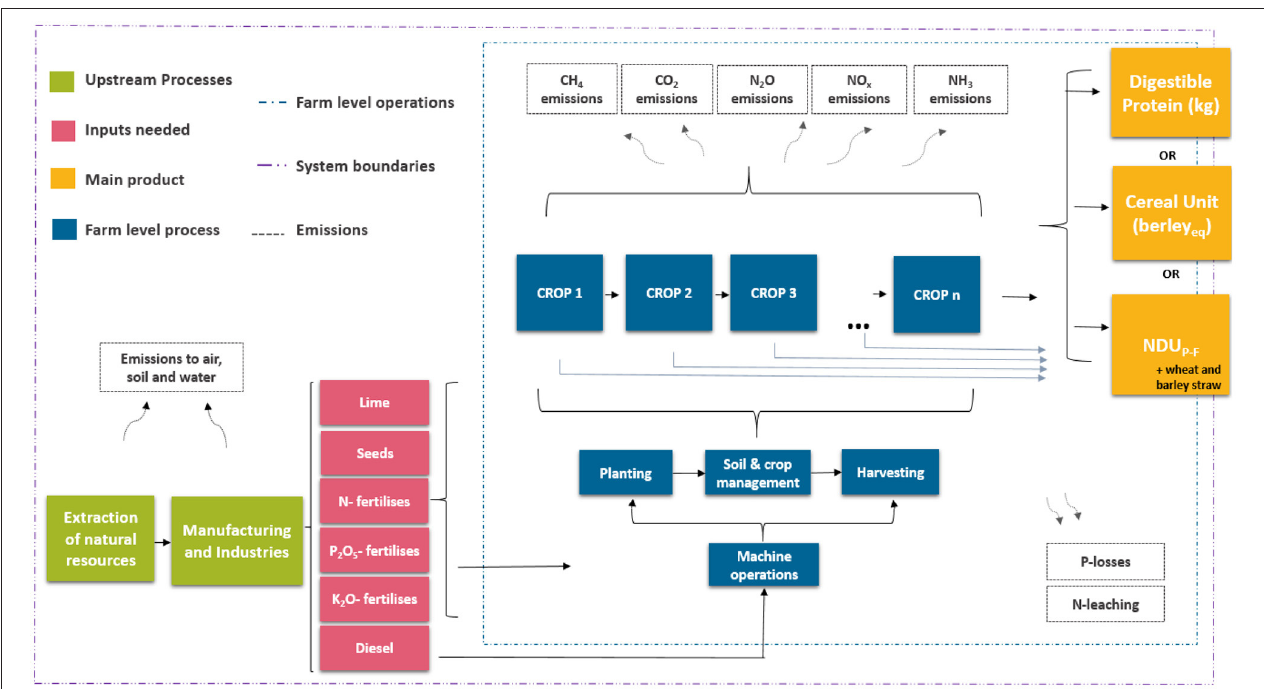
FIGURE 1 | LCA boundaries of the rotation systems to deliver nutrition to animals (DP and CU) and to humans (NDU P − F